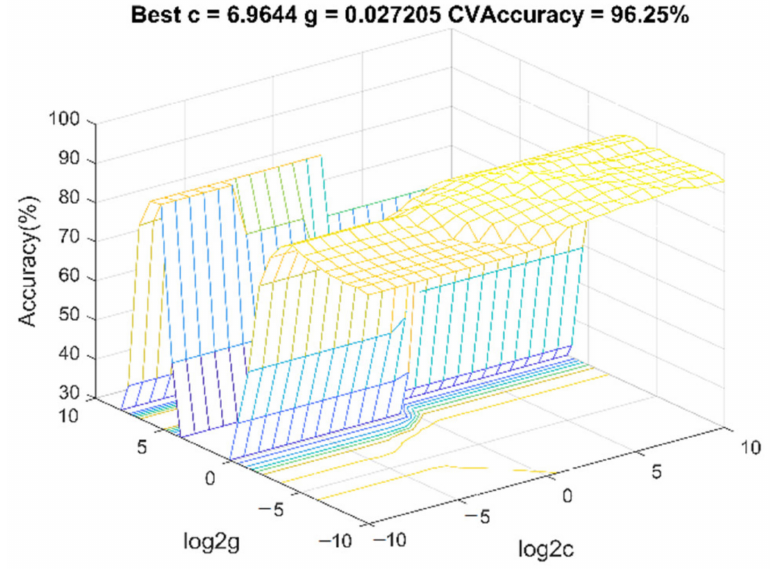
Figure 7. The results of grid search method of